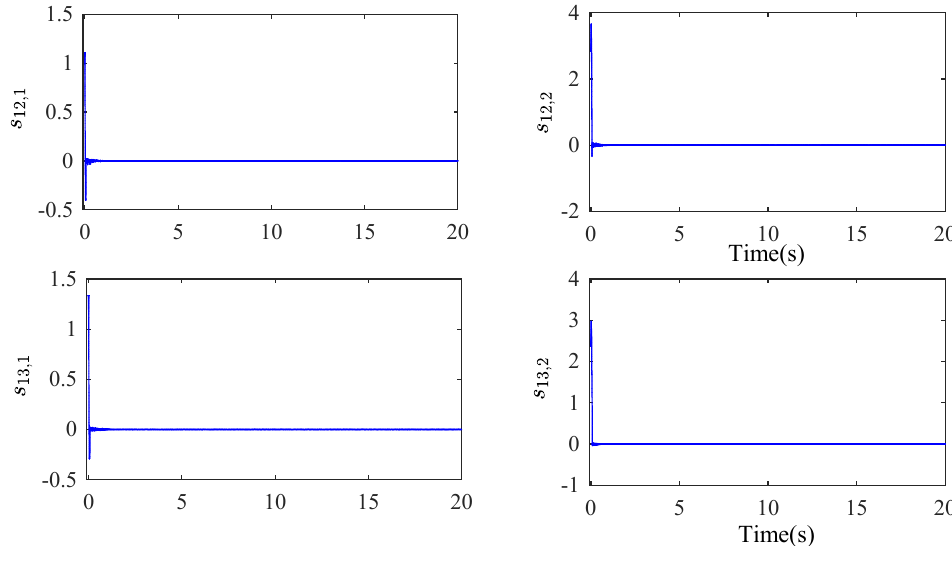
Figure 6. The acceleration and angular acceleration of follower robot 3; (a) α 3 ; (b) β 3.